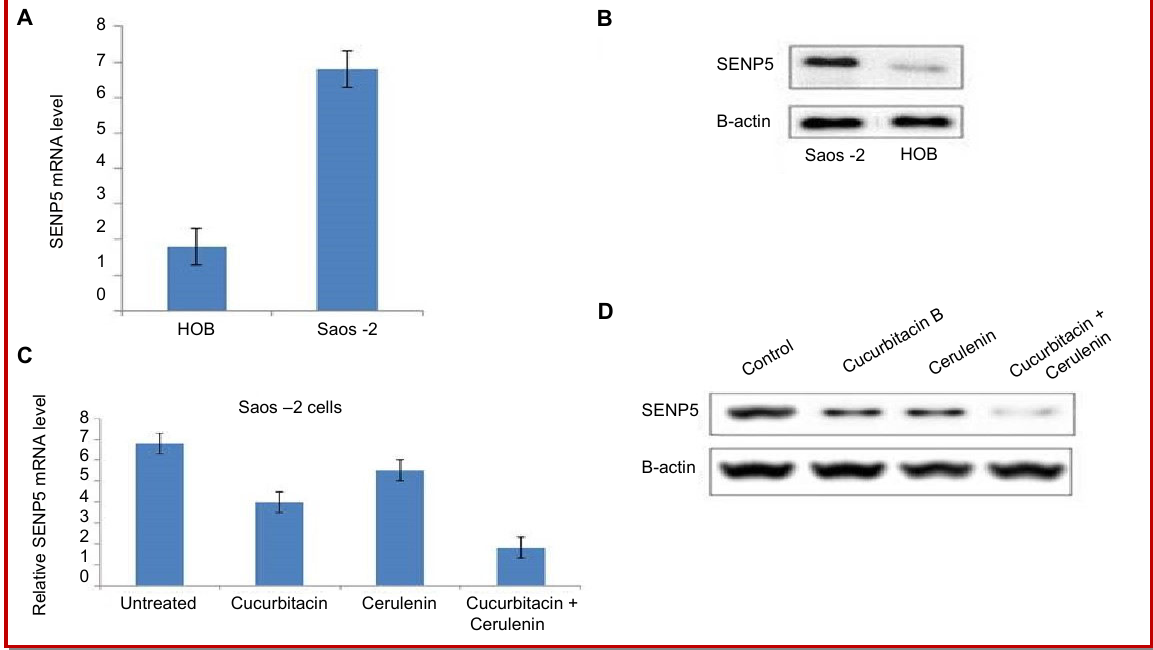
Figure 3: SENP5 is overexpressed in osteosarcoma cell lines. (A) mRNA expression and (B) protein levels of SENP5 in Saos-2 oste- osarcoma cell lines. Inhibition of SENP5 expression by cucurbitacin B and cerulenin treatment. (C) Concentration-dependent inhi- bition of SENP5 expression in Saos-2 cells. (D). Time-dependent inhibition of SENP5 expression in Saos-2